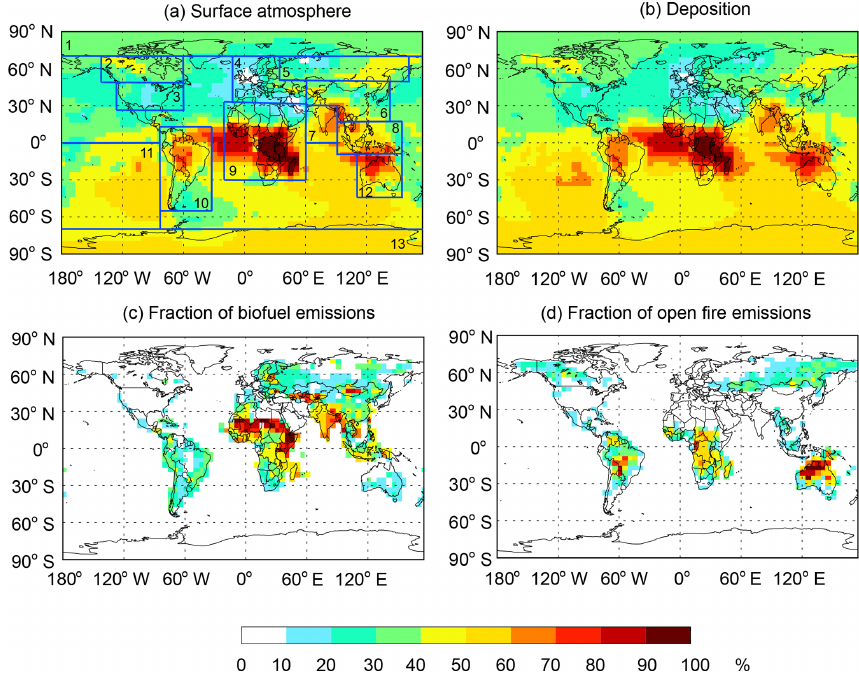
Figure 3. Annual (a) f bb of BC in the atmosphere at surface, (b) f bb of BC deposition, (c) fraction of biofuel emissions and (d) fraction of open fire emissions. Data are averaged for 2007–2013. Also shown in panel (a) are regions discussed in the text: the Arctic (1), Canada (2), the US (3), Europe (4), Siberia (5), eastern (E) Asia (6), southern (S) Asia (7), southeastern (SE) Asia (8), Africa (9), S America (10), S Pacific (11), Australia (12) and the Antarctic